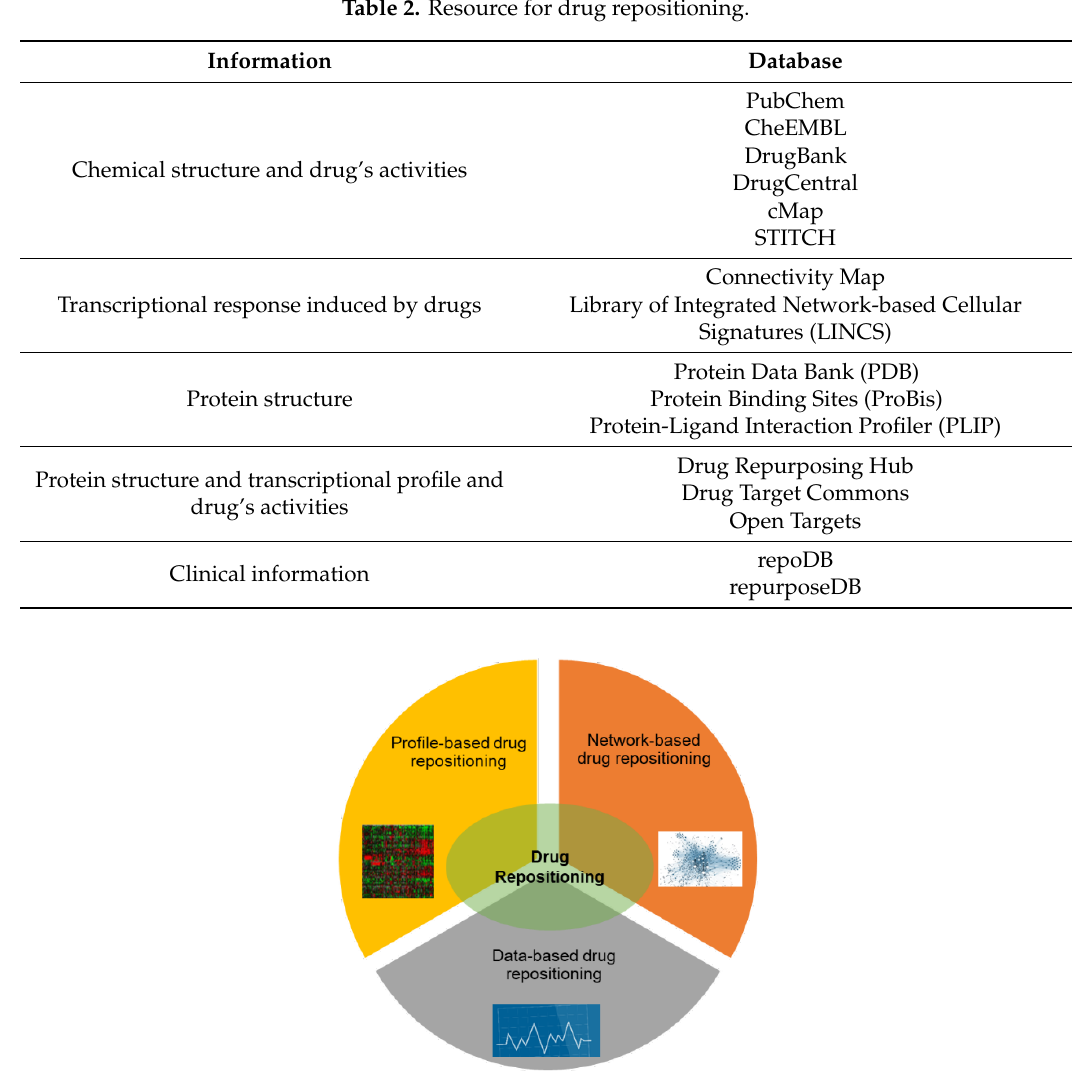
Table 2. Resource for drug repositioning.